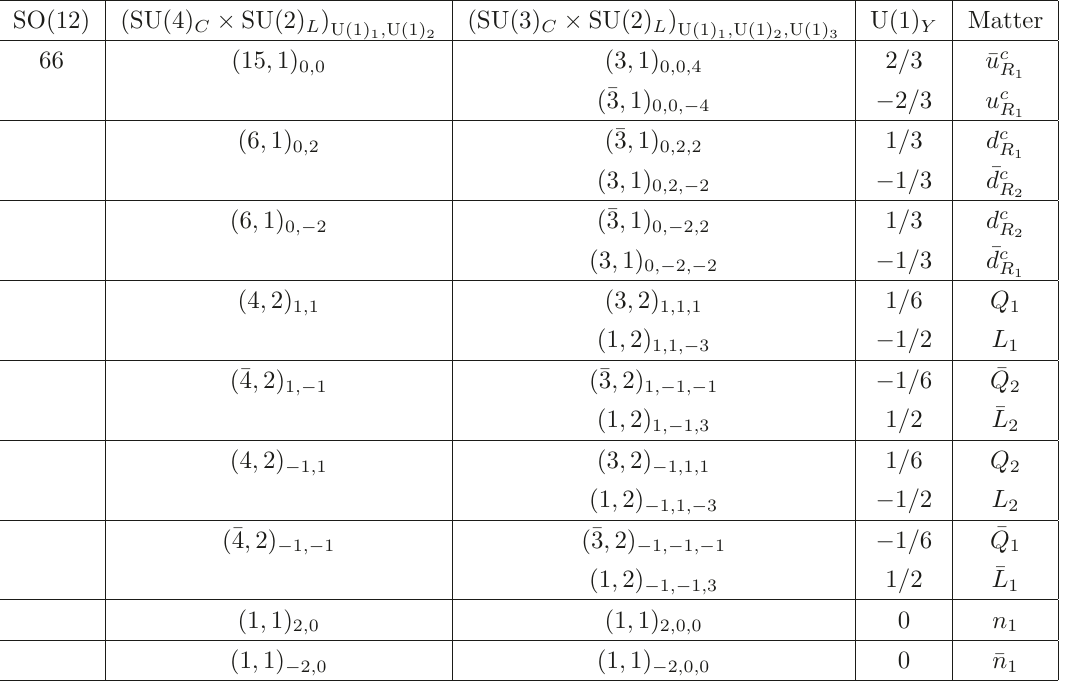
Table 1 . Matter content from the adjoint representation of SO(12), where the hypercharge U(1) Y is identified as U(1) 3 / 6. Here, the subscript indices label the U(1) charges.